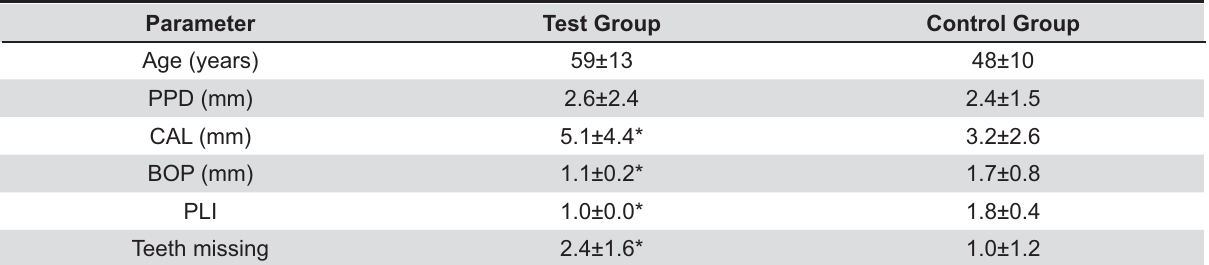
Table 1- Clinical periodontal conditions of test and control group patients (t-test)